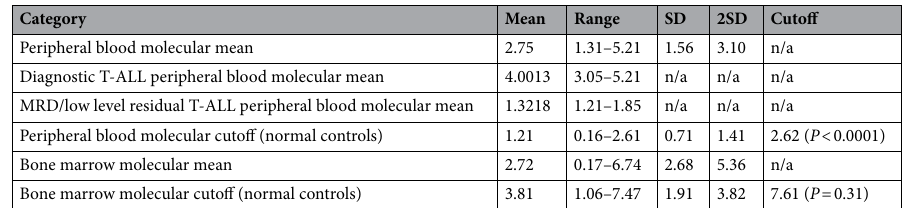
Table 3. AKR1C3 RT-qPCR cutoff values in peripheral blood and bone marrow samples. Means, ranges, standard deviations, and cutoffs of the data illustrated in Fig. 3. A statistically significant relative expression cutoff relative expression of 2.62 is observed among peripheral blood specimens, but not for bone marrow samples. Cutoff values were calculated against negative controls.